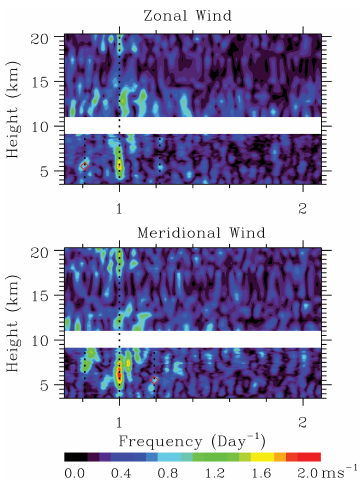
Figure 3. Lomb–Scargle periodogram of high-pass-filtered zonal wind (top) and meridional wind (bottom) in April 2012. The max- imum spectral magnitudes for the zonal and meridional winds are 1.84 and 2.07ms − 1 , respectively. The two red diamonds represent the sidelobes at 5.51km.